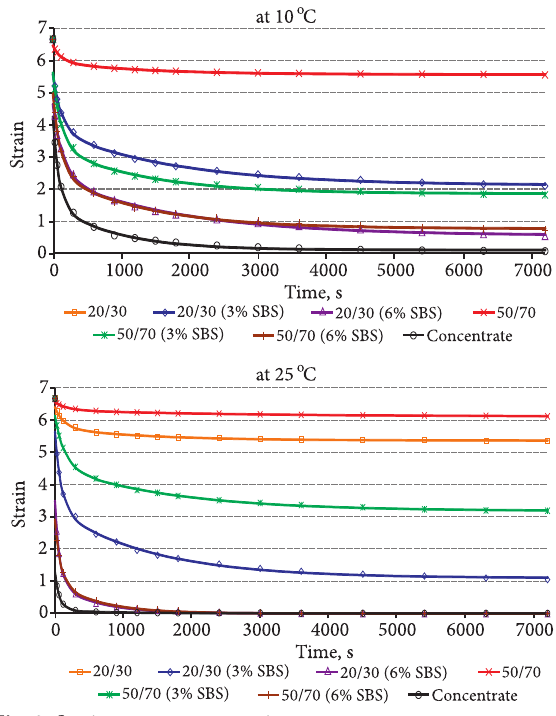
Fig. 3. Strain recovery versus time curves